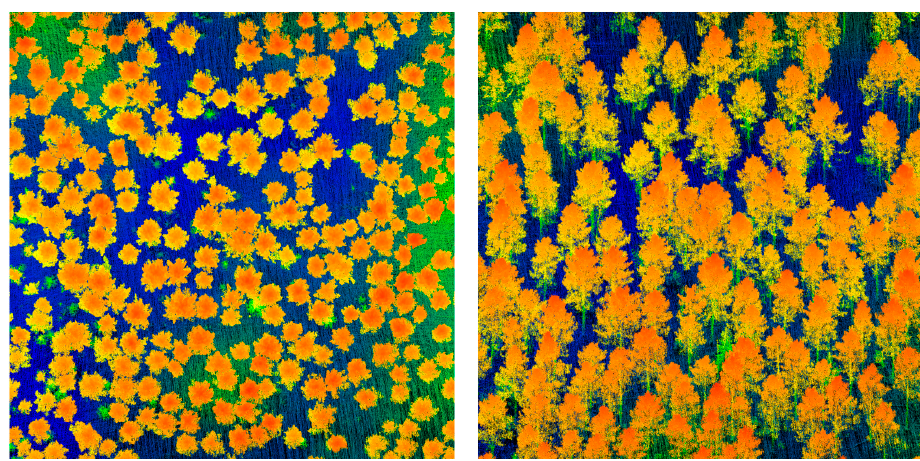
Figure 1. The applied UAV laser scanning system.